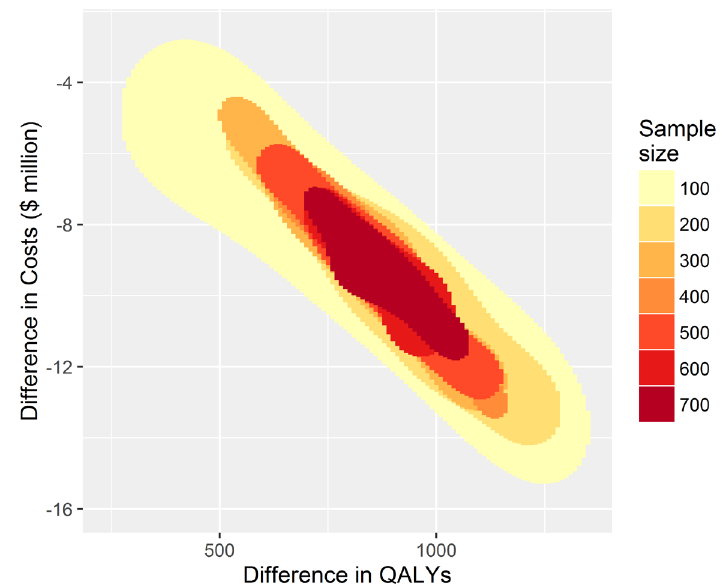
Figure 2. The conclusion for decision-making becomes more uncertain but does not change with decreasing sample size. The x-axis shows the QALY gains for TEXT ME over usual care, and the y-axis shows the cost